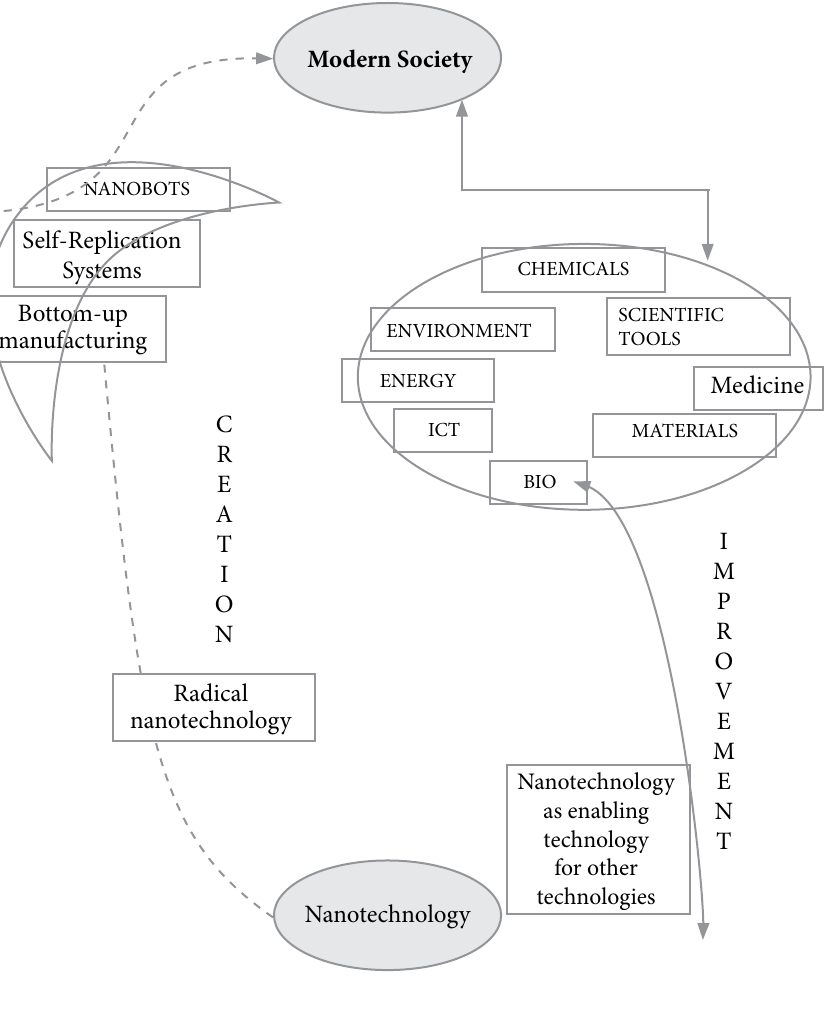
Fig. 2. Different nanotechnology scenarios (self-compilation)